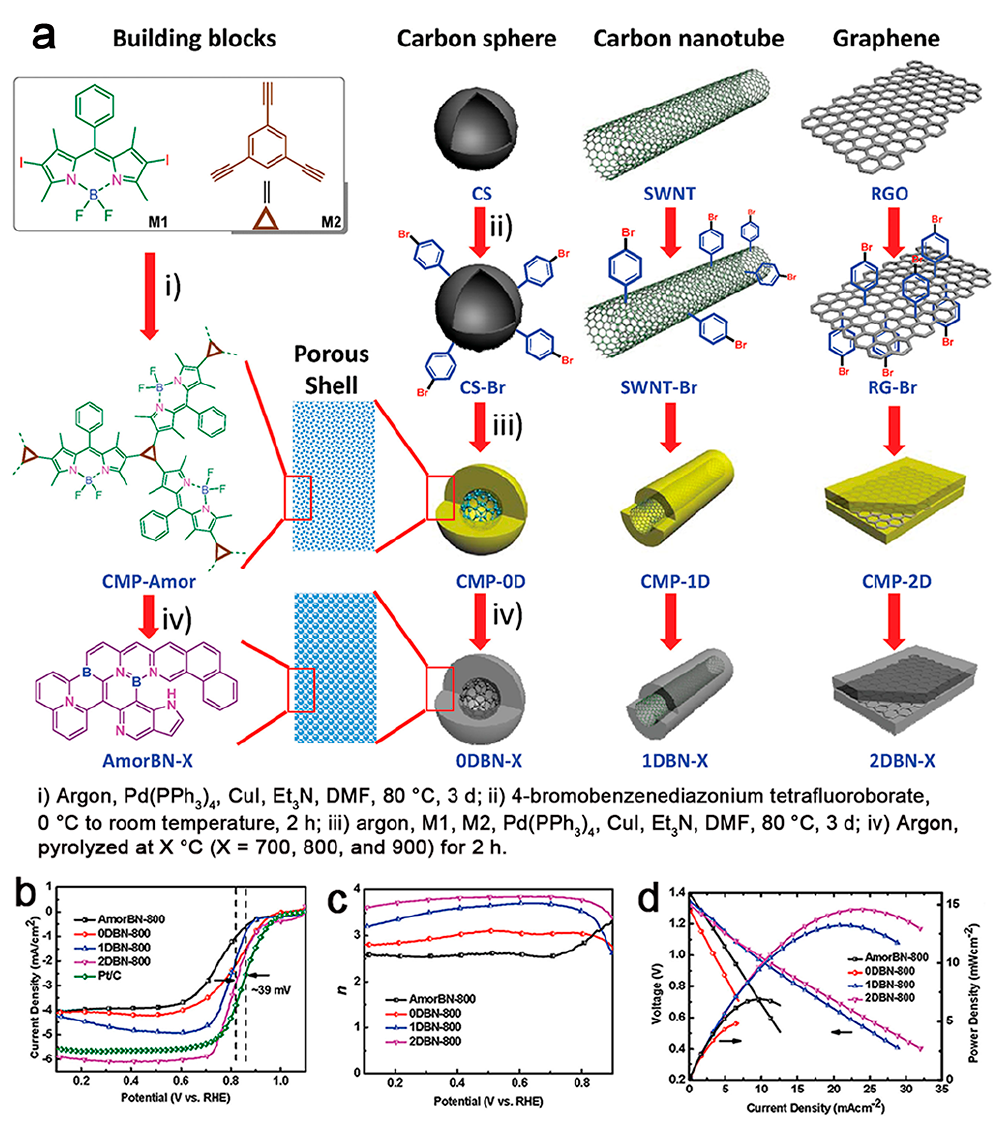
Figure 5. A synthesis illustration of BODIPY-based porous polymers (conjugated microporous polymers (CMP)) CMP-0D , CMP-1D and CMP-2D ( a ); linear sweep voltammetry curves of AmorBN-800 , 0DBN-800 , 1DBN-800 , 2DBN-800 and Pt/C in O 2 -saturated 0.1 M KOH solution at 1600 rpm at a scan rate of 5 mV·s − 1 ( b ); electron-transfer number for AmorBN-800 , 0DBN-800 , 1DBN-800 and 2DBN-800 as a function of the electrode potential ( c ); polarization curve (V–i) and the corresponding power density plot of the battery using AmorBN-800 , 0DBN-800 , 1DBN-800 and 2DBN-800 as the cathode catalysts ( d ). Reprinted with permission from [46]. Copyright 2015, Wiley-VCH.